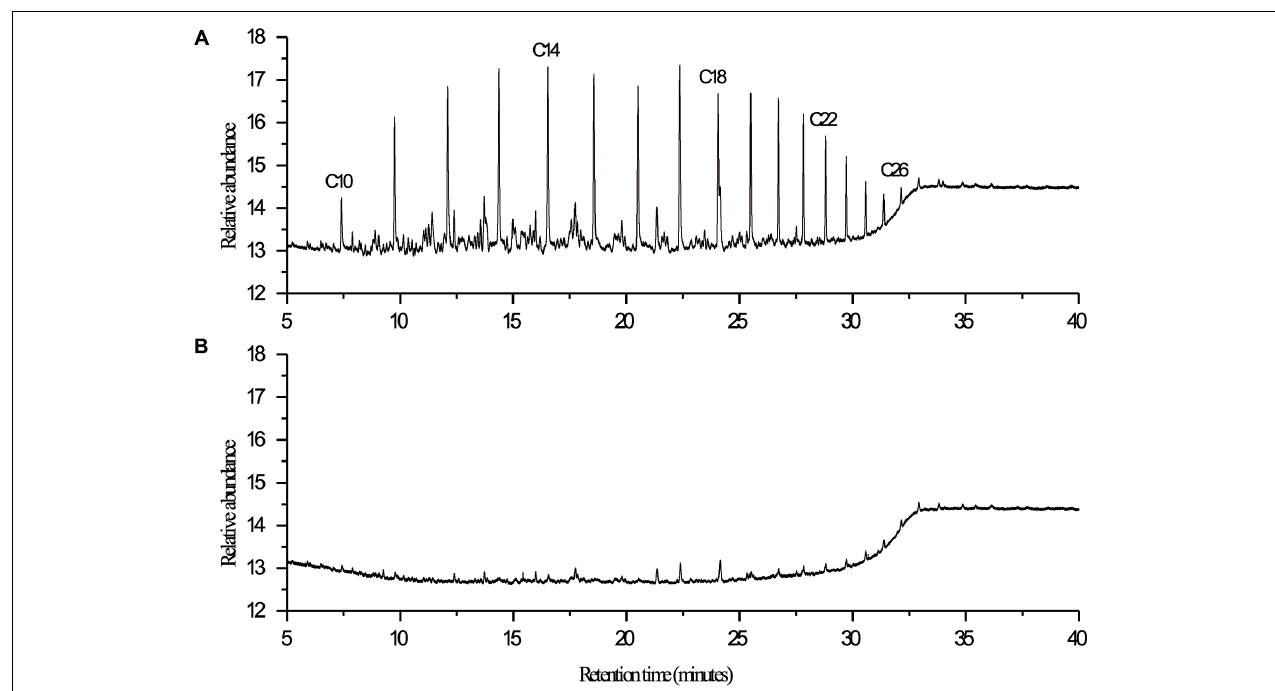
FIGURE 2 | GC-FID chromatograms of diesel oil extracted at 7th day from (A) control and (B) experimental flask in biodegradation study with endophytic isolate L10. Degradation of diesel oil was carried out under aerobic conditions at 30 ◦ C in 300-mL Erlenmeyer flasks containing 100 mL of MS medium and 5 g/L of diesel oil. Control was performed by inoculating with the boiled cells of isolate. Hydrocarbons were extracted from the culture medium with an equal volume of n -hexane, analyzed using a gas chromatograph equipped with an FID detector (GC-FID, 7890A, Agilent, United States), and quantified in comparison to the n -alkane homologous